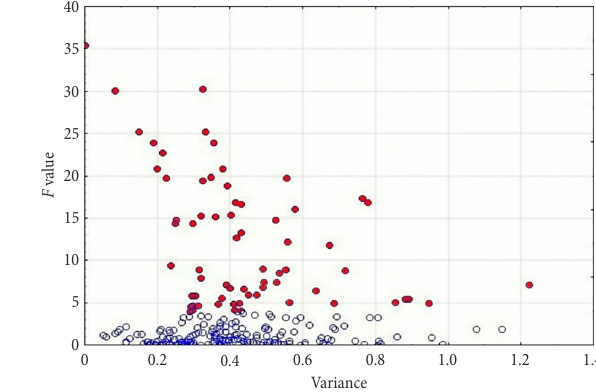
Fig. 5. Display of values F and v for subsections that are significantly different